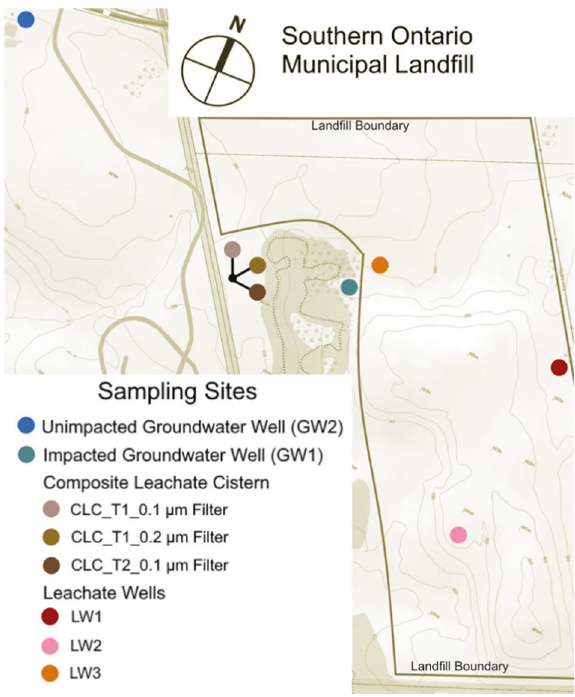
Fig. 1 Map of land fi ll sampling locations at the Southern Ontario land fi ll. Two groundwater wells accessing the adjacent aquifer were sampled. The three samples from the leachate collecting cistern were all sampled from the same cistern at two time points. Two fi lter sizes were used for collecting microbial biomass on July 14, 2016 (CLC_T1_0.1 µm fi lter and CLC_T1_0.2 µm fi lter) and one fi lter size was used on July 20, 2016 (CLC_T2_0.1 µm fi lter). The three leachate wells are located within the active land fi ll, and leachate from these wells is pumped to the leachate collecting cistern. The catchment area for LW3 has an active leak in fi ltrating into the groundwater near GW1. GW1, the impacted groundwater well, shows geochemical evidence of leachate in fi ltration into the aquifer, where GW2 is upstream and shows no leachate chemical signature in the groundwater. The topographic map was modi fi ed from maps provided by the Ontario Ministry of Natural Resources and